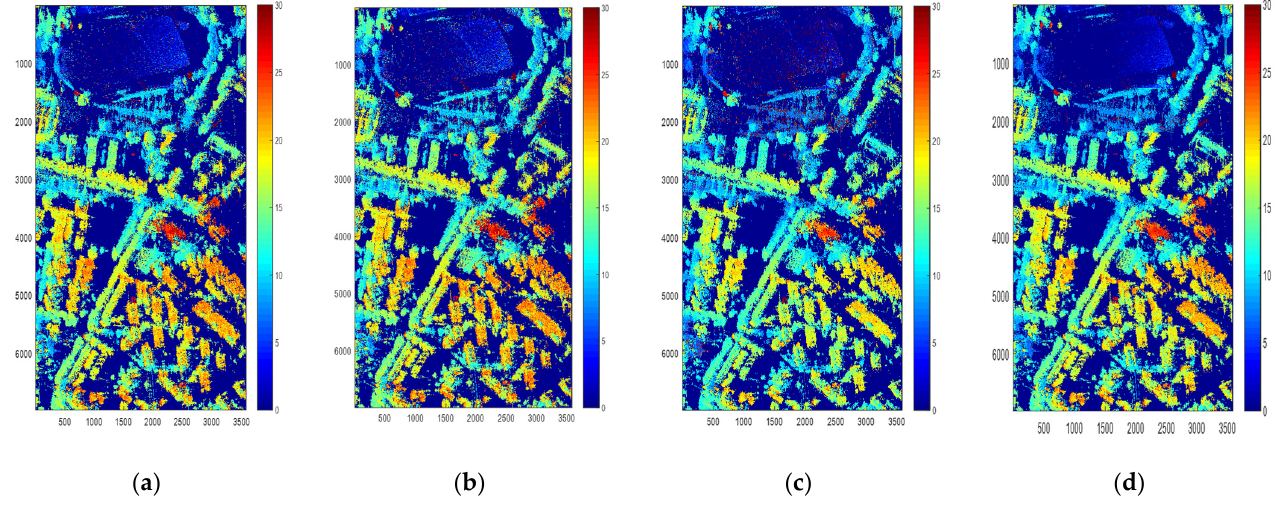
Figure 8. Height inversion of different polarization modes (meters). ( a ) Height of P s . ( b ) Height of P d . ( c ) Height of P v . ( d ) Height of polarimetric interferometric optimal